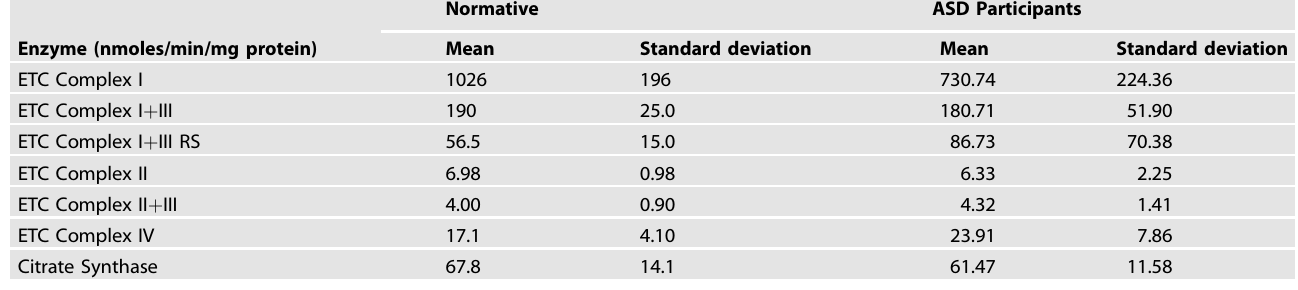
Table 3. Electron transport chain complex activity in Fibroblasts for clinical normative reference range and for fi broblasts derived from children with autism spectrum